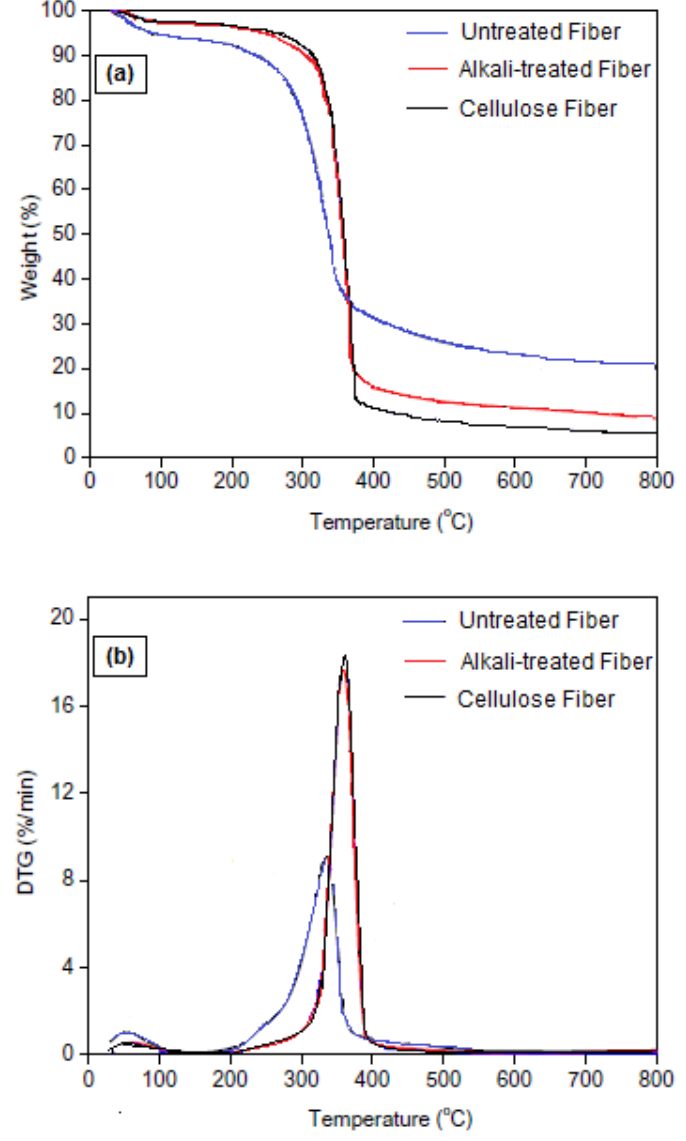
Figure 4. ( a ) TG and ( b ) DTG thermograms of the untreated, alkali-treated and cellulose fibers. Table 4. Thermal degradation temperatures and charred residue of Ziziphus jujuba fibers before and after different treatments (10 °C/min, under N 2